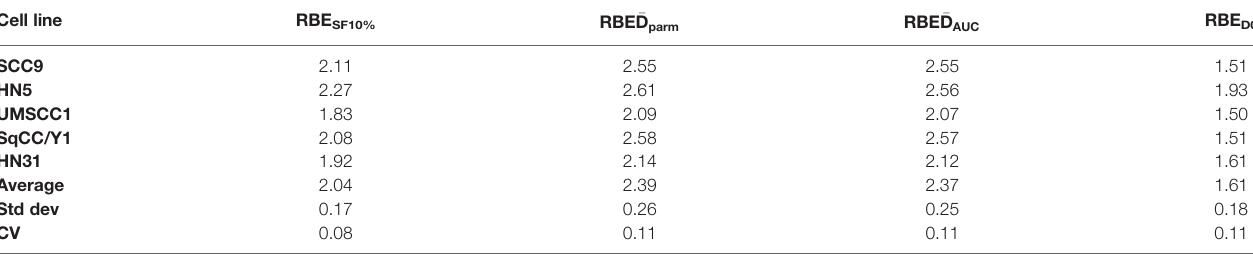
TABLE 2 | Limiting slopes, mean inactivation doses, and RBEs using different methods of determination. Cell line